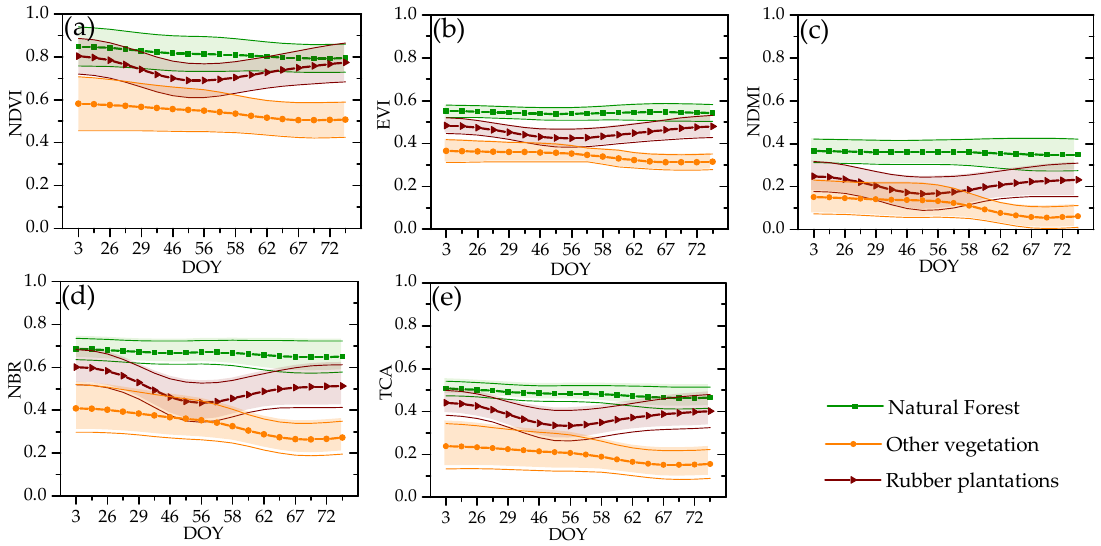
Figure 8. Time series indices of the 5 indices for land covers in 2015: ( a ) NDVI time series curve; ( b ) EVI time series curve; ( c ) NDMI time series curve; ( d ) NBR time series curve; ( e ) TCA time series curve.